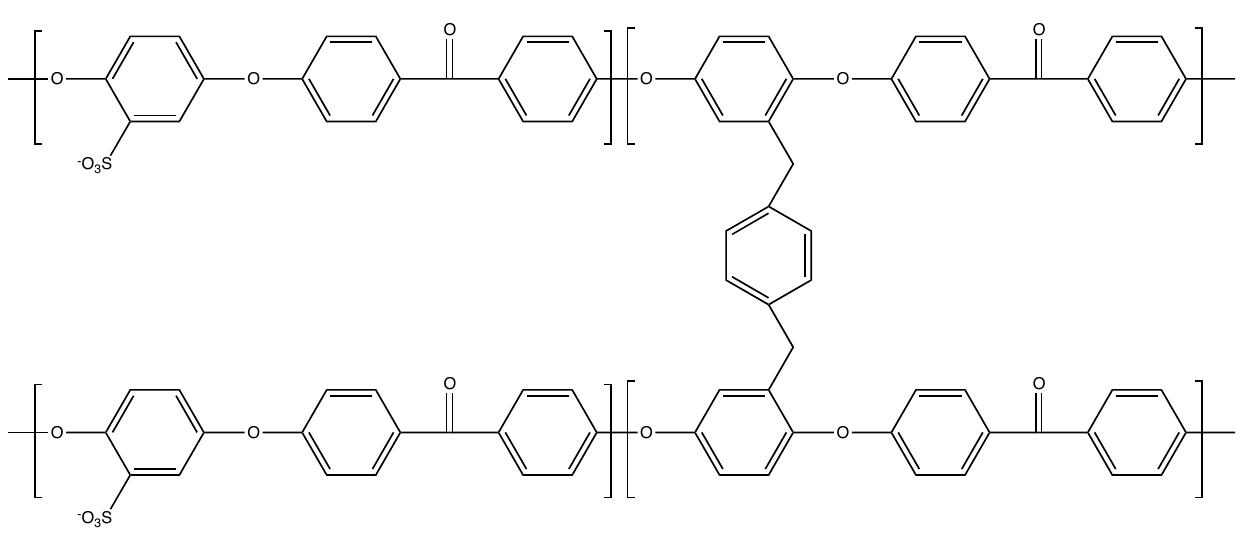
Figure 5. Activated and deactivated positions for an electrophilic substitution reaction on a SPEEK